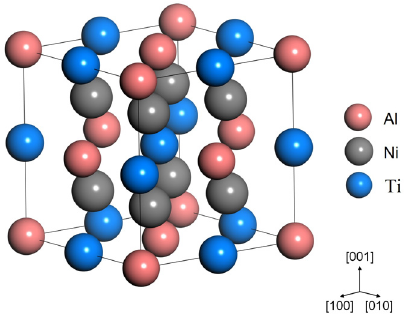
Figure 1. Crystal structure calculated for AlNi 2 Ti compounds.